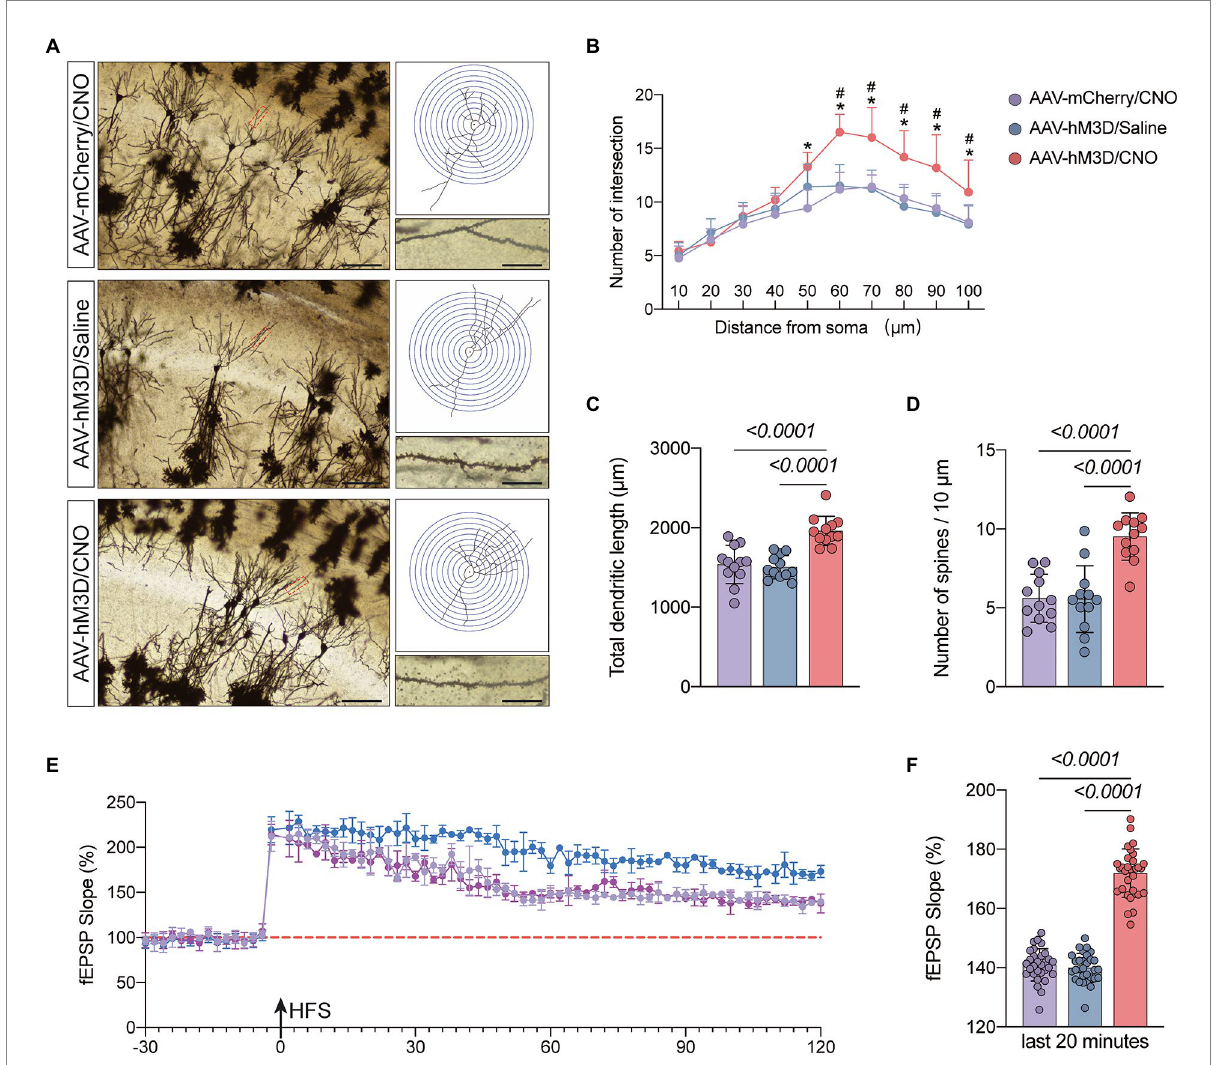
FIGURE 6 Effects of activation of Gq pathways in astrocytes on the structure and function of synaptic plasticity at postoperative day 11. (A) Golgi staining of the CA1 region of the mouse hippocampus (×200, n = 3), Sholl analysis and magnification of synapses (×1,000), scale bar = 100 or 20 μ m. (B–D) Quantitative analysis of total synaptic length, synaptic spine density and synaptic number. (E) Recording and analysis of local field potentials in the CA1 region of the hippocampus in response to stimulation of Schafer’s lateral branch fibers ( n = 3). (F) Average fEPSP Slop in the last 20 min. * p < 0.05, compared with the AVV-mCherry/CNO group. # p < 0.05, compared with the AVV-hM3D/Saline group. Data were expressed as mean ± SD and analyzed by ANOVA test with a Tukey post hoc test. The p -values are shown in the